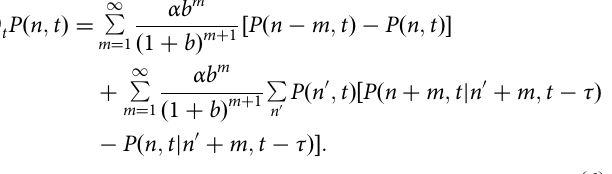
algorithm (SSA) modi fi ed to incorporate delays (speci fi